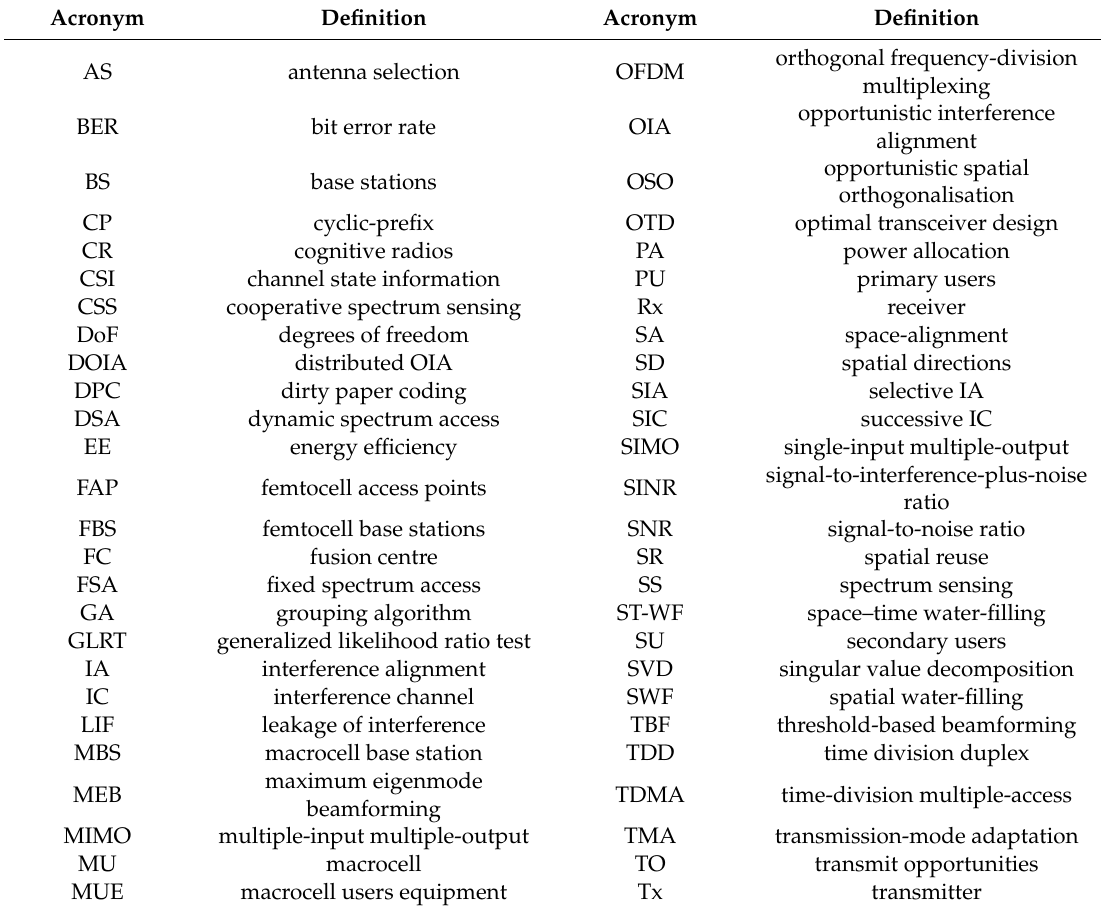
Table 1. Summary of Important